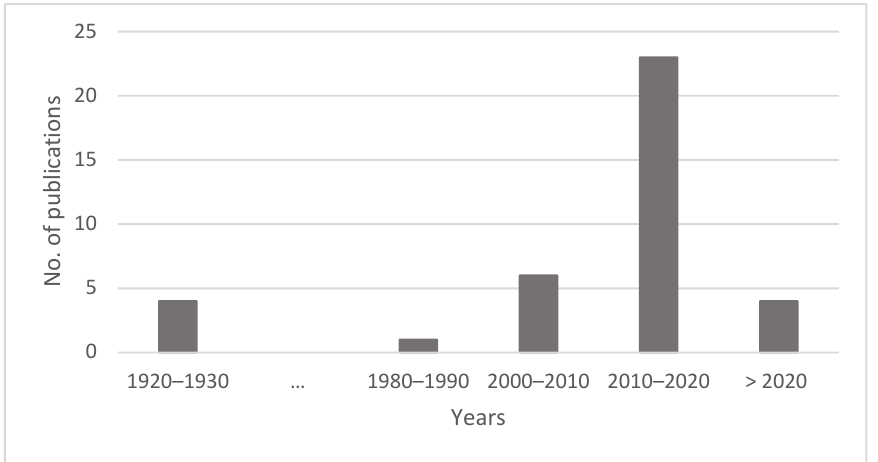
Figure 1. Temporal evolution of the number of publications on forest insurance within our sample of 38 articles.